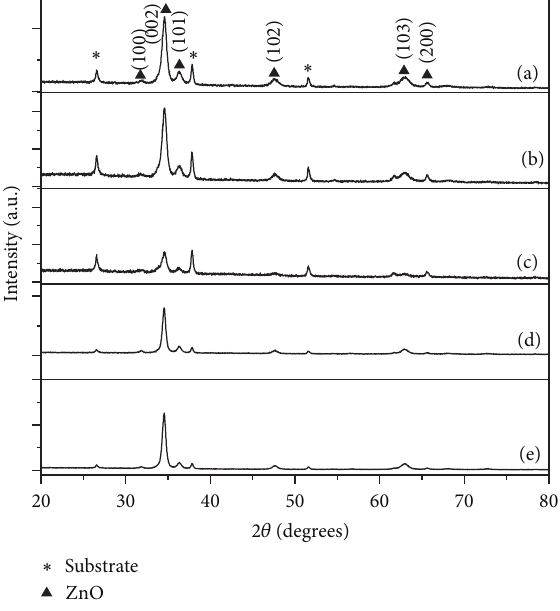
Figure 1: X-ray diffraction spectra of doped ZnO films with different concentrations of doping. (a) ZnO, (b) 0.1 𝜇 M Cu 2+ , (c) 0.3 𝜇 M Cu 2+ , (d) 1.3 𝜇 M Cu 2+ , and (e) 26.4 𝜇 M Cu 2+